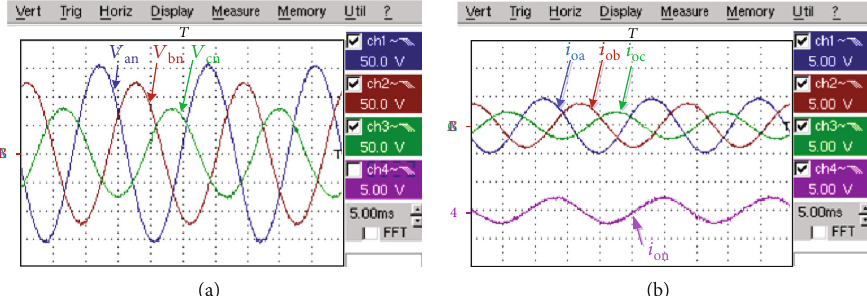
Figure 9: The experimental results of hybrid controller under unbalanced reference voltages: (a) load voltages, ch1-ch3 (50 V/div); (b) load currents, ch1-ch4 (13A/div).